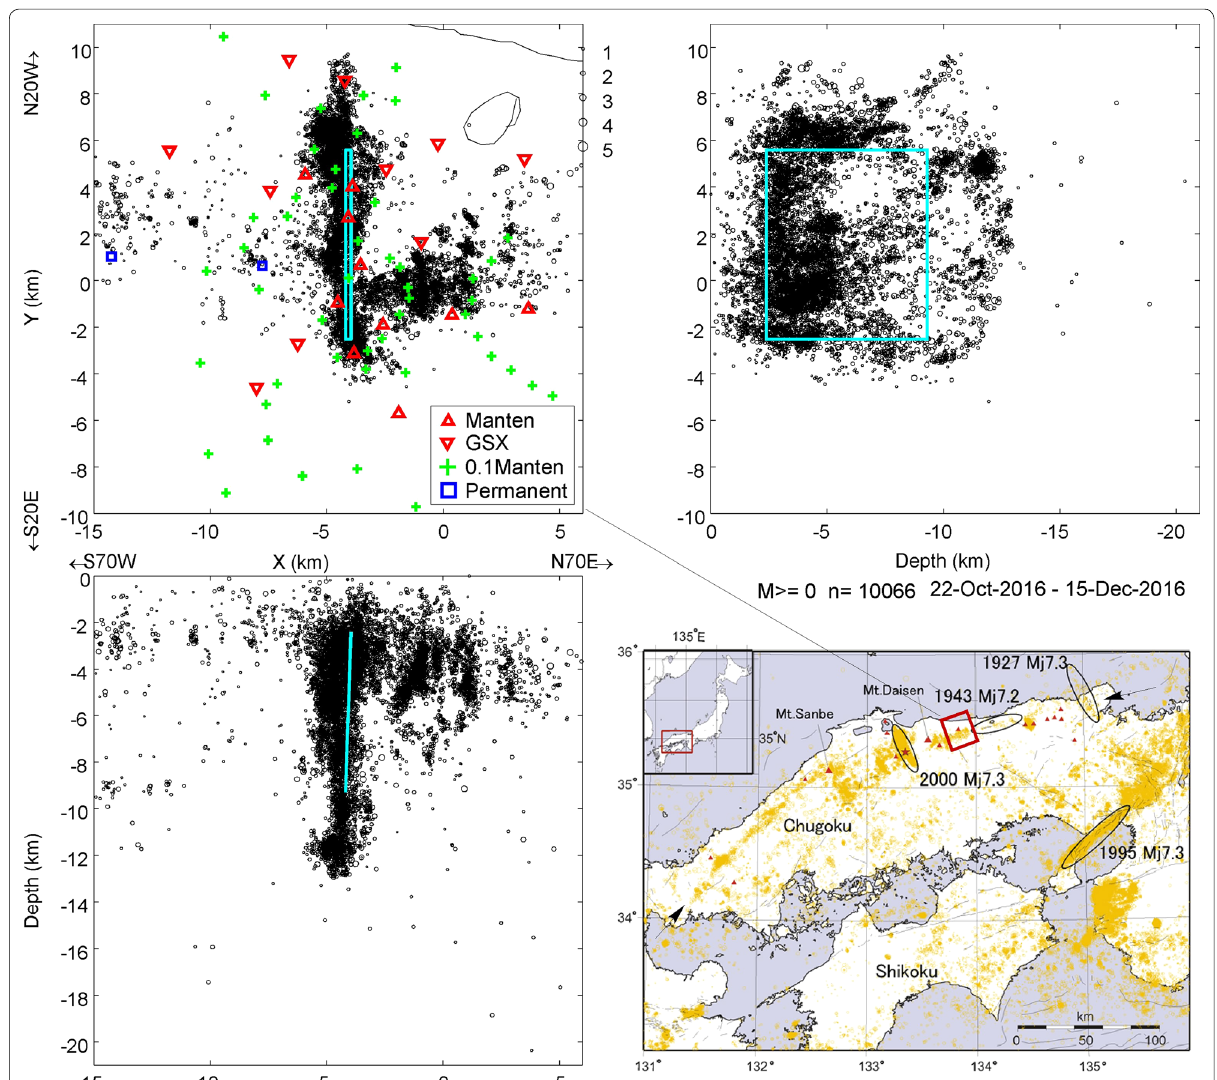
Fig. 1 Distribution of aftershock-observation stations and aftershock hypocenters. Locations of seismic stations of “Manten”, “0.1 Manten” and GSX three-component seismographs, and permanent stations (operated by NIED, and JMA) are indicated by red triangles, red reversed triangles, green crosses, and blue rectangles, respectively. Black dots are aftershocks that occurred from October 22 to December 15, 2016 (analyzed in this study). Cyan rectangle indicates the mainshock fault estimated from InSAR and GNSS data assuming uniform slip (GSI 2017). The red rectangle in the large-scale map indicates the study area. Yellow dots in the large-scale map show the epicentral distribution of earthquakes of depths < 30 km. Ellipses are focal areas of earthquakes of M JMA > 7.0 that occurred in past 100 years and red closed triangles are active volcanoes. The arrows indicate the San’in seismic